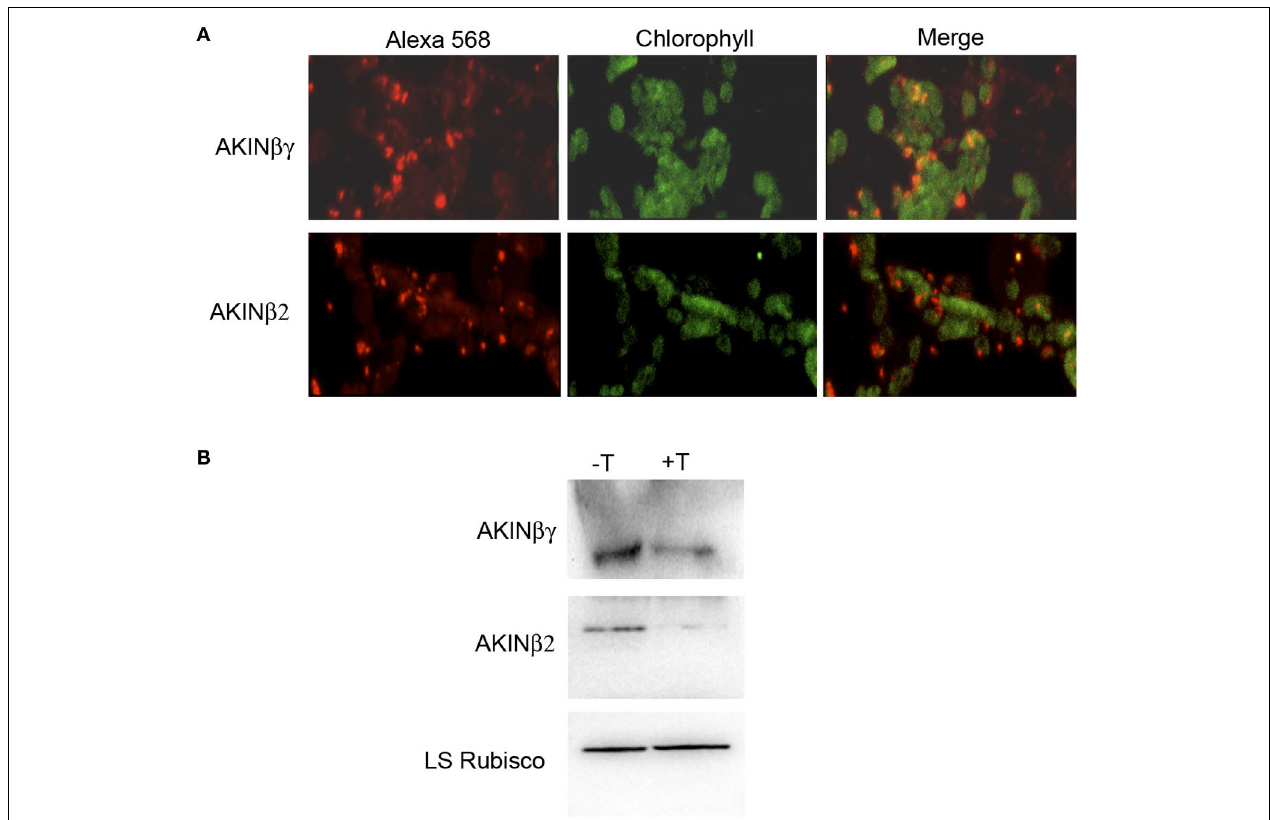
FIGURE 3 | Immunolocalization of AKIN βγ and AKIN β 2. (A) Leaf sections incubated with AKIN βγ - and AKIN β 2-specific antibodies showing goat anti-rabbit Alexa 568-fluorochrome staining (red signal, 40 × ), chlorophyll (green signal, 40 × ) and overlaid images of the Alexa 568 fluorochrome and